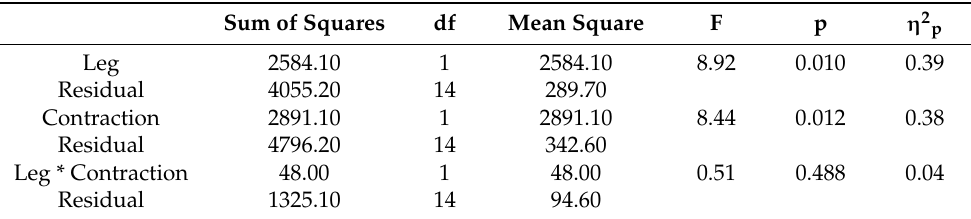
Table 1. Two-way repeated measures ANOVA for isokinetic knee torques.